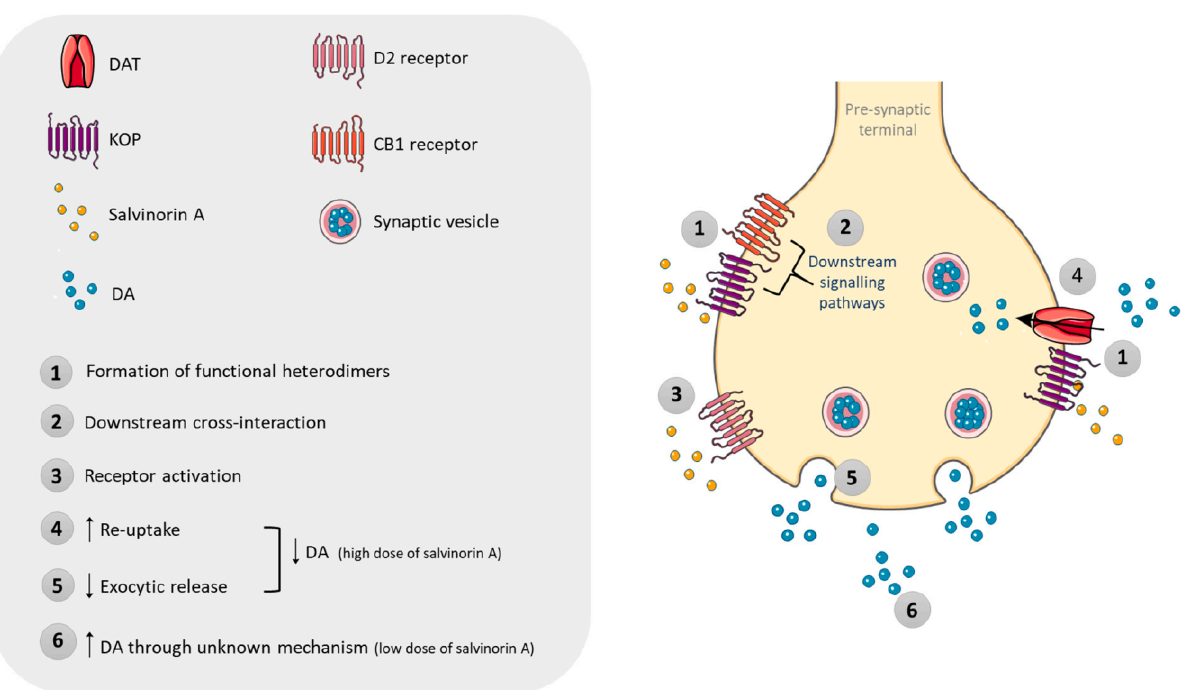
Figure 5. Proposed salvinorin A interaction with the endocannabinoid and dopaminergic systems. Of note, the represented mechanisms are entirely speculative [86,108,127,135], alternative explanations for the impact of salvinorin A on dopamine (DA) levels, including the binding of the drug to the κ -opioid receptor (KOP) in the ventral tegmental area, reducing DA release in the striatum and the nucleus accumbens. CB1 receptor: Cannabinoid receptor type-1; D2 receptor: Dopamine receptor type-2; DAT: Dopamine re-uptake